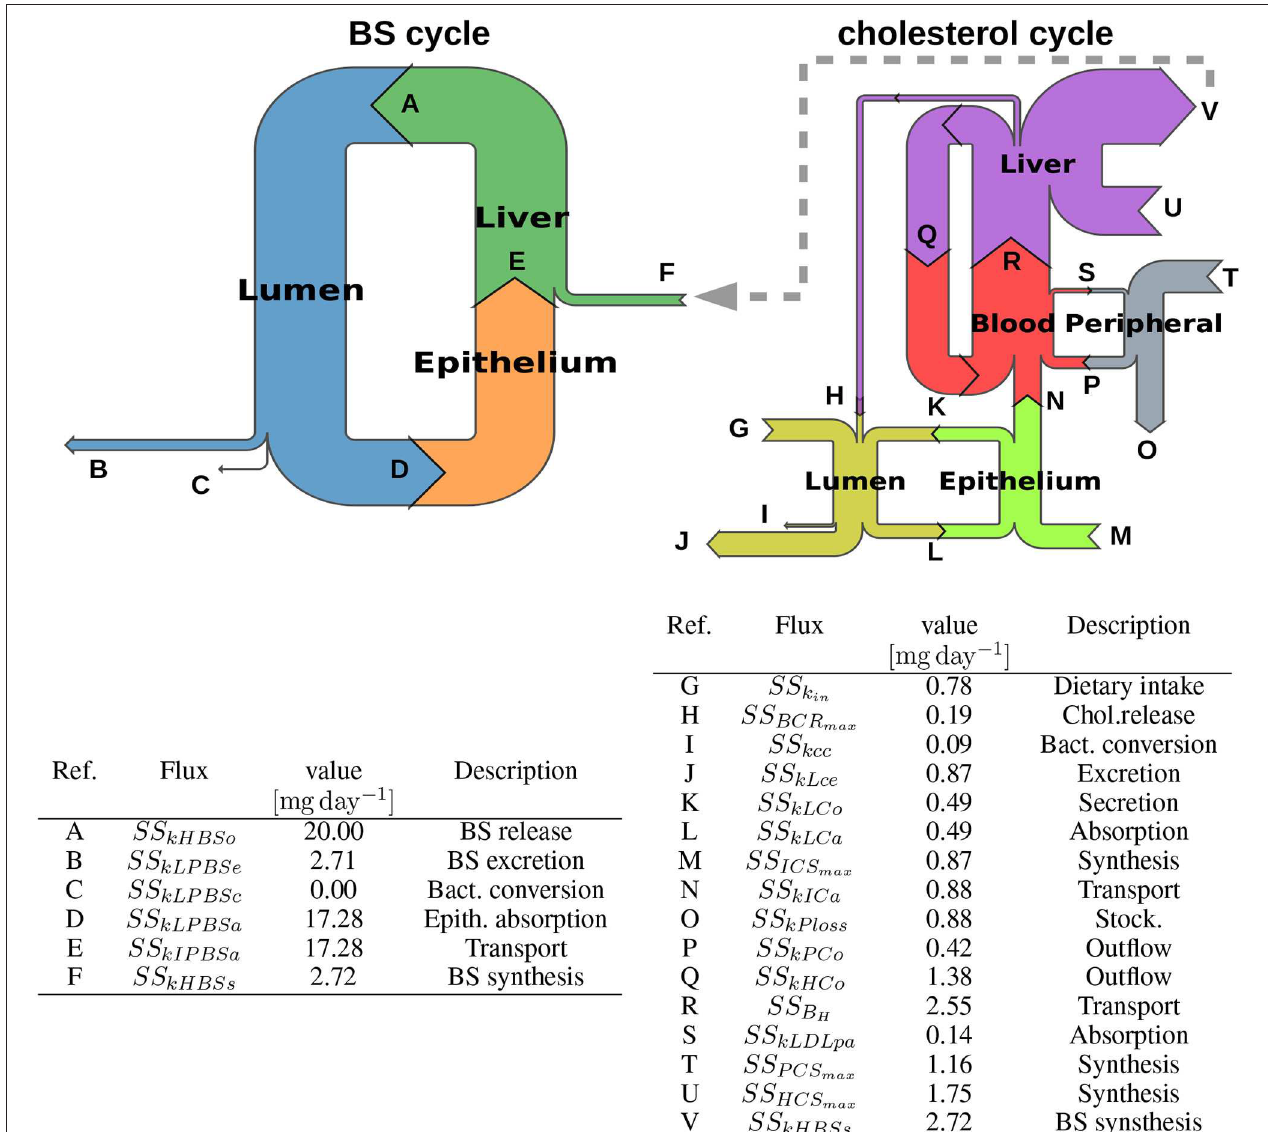
FIGURE 5 | Sankey diagrams of the BS and cholesterol cycles. We display the Sankey diagrams of the BS and cholesterol cycles at steady state. Each row is proportional to the corresponding flux ( mgday − 1 ), and is displayed with a letter referring to the corresponding model coefficient, its steady-state value and its nomenclature in the model, gathered in the tables. We note that there is a huge discrepancy of flow magnitude between the two cycles, the BS cycle involving much more higher mass transfers than the cholesterol one. Thus, we could not represent the diagrams with the same scale, resulting in different arrow thicknesses for the BS synthesis, despite an equal value for this flux in the two cycles. We emphasize this scale change and the connection between both cycles with the gray dashed arrow. Flux details can be found in Table S6 and Table 2